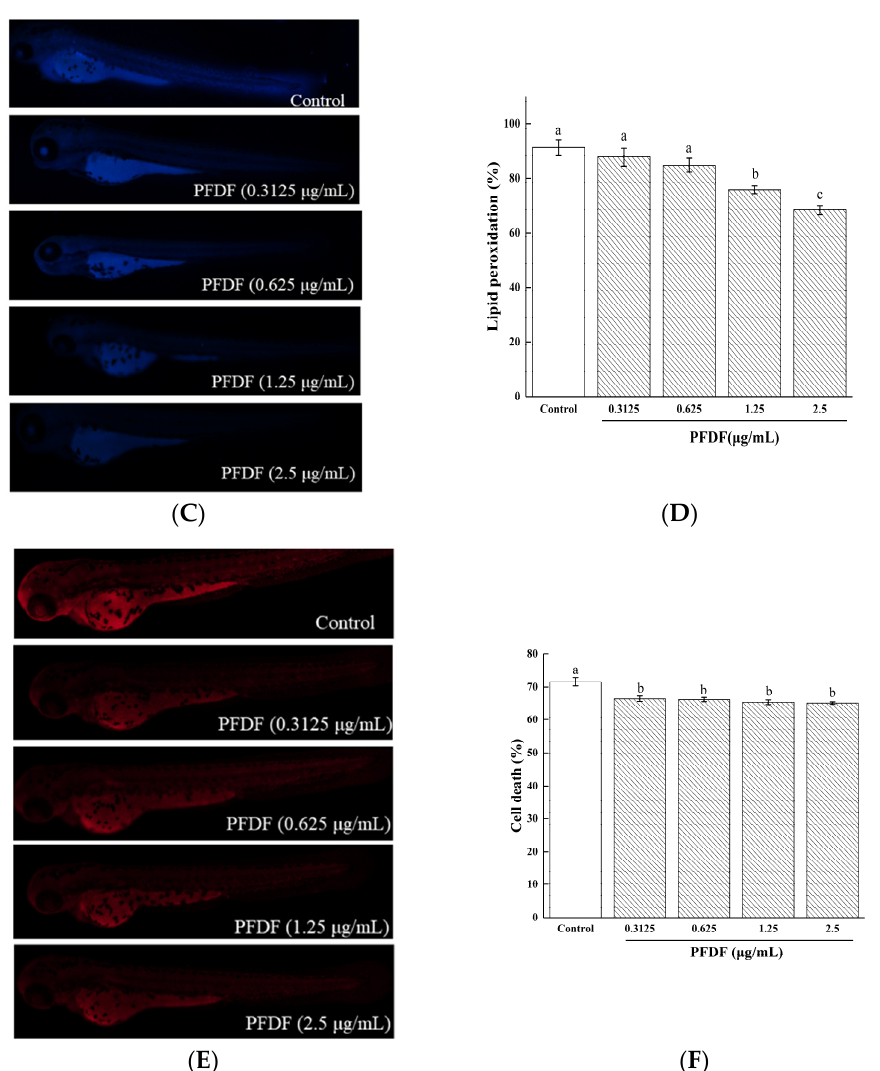
Figure 7. The effects of various concentrations of PFDF on ROS production ( A , B ), lipid peroxidation ( C , D ), and cell death ( E , F ) in zebrafish embryos measured by fluorescence microscopy and image J software. Experiments were performed in triplicate, and data are expressed as the mean ± SE. Different lowercase superscript letters denote statistically significant differences among different concentrations ( p < 0.05).